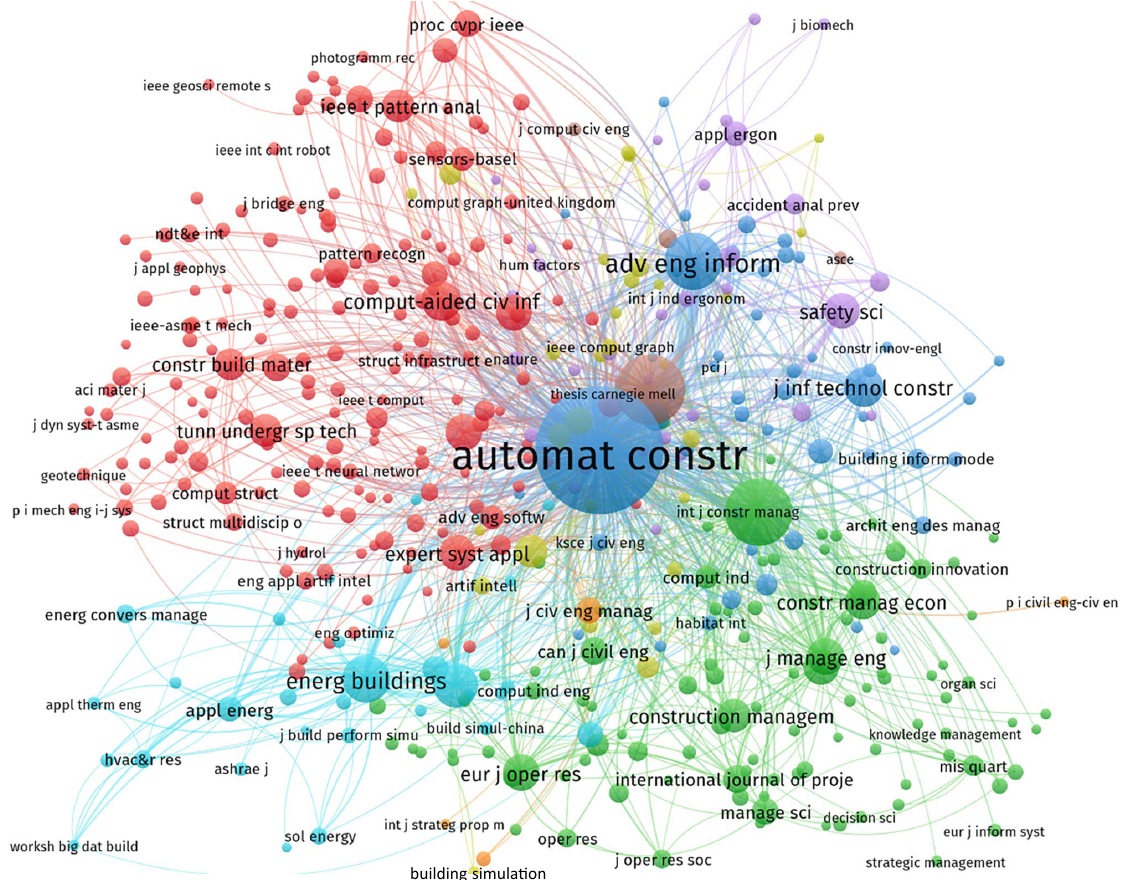
Figure 5. Journal co-citation network Table 7. Performance measures of